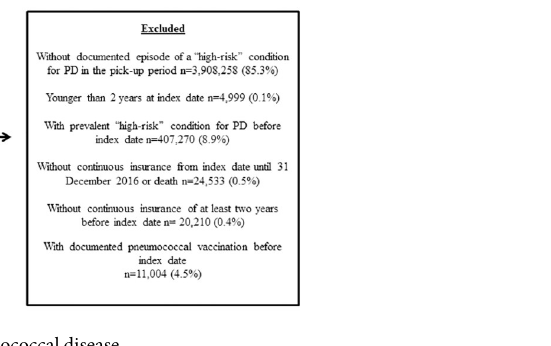
Fig 1. Study flow chart. PD = Pneumococcal